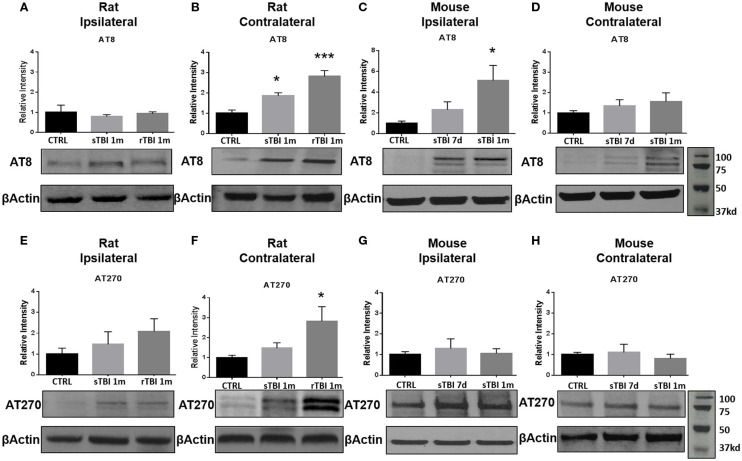
Blast and closed-head injury models both induced tau hyperphosphorylation. (A) Immunoblots show no significant difference in tau phosphorylation at serine sites 199/202 and threonine site 205 (AT8) at 1 month after single and repeat blast exposures in the ipsilateral rat hippocampus. (B) A significant increase in AT8 expression was measured after single (*p < 0.05 vs. CTRL) and repeat blast exposure (***p < 0.001 vs. CTRL) in the contralateral rat hippocampus. (C) AT8 expression was significantly increased at 1 month after closed-head injury in the ipsilateral mouse hippocampus (*p < 0.05 vs. CTRL). (D) No significant differences were observed in AT8 expression in the contralateral mouse hippocampus. (E) Immunoblots show no significant difference in tau phosphorylation at threonine site 181 (AT270) at 1 month after single and repeat blast exposure in the ipsilateral rat hippocampus. (F) A significant increase in AT270 expression was measured at 1 month after repeat blast exposure (*p < 0.05 vs. CTRL) in the contralateral rat hippocampus. (G) No significant differences were observed in AT270 expression in the ipsilateral mouse hippocampus, (H) or the contralateral mouse hippocampus after closed-head injury. One-way ANOVA Tukey’s post hoc analysis (values represent mean ± SEM; normalized to β-actin) (n = 3–5).